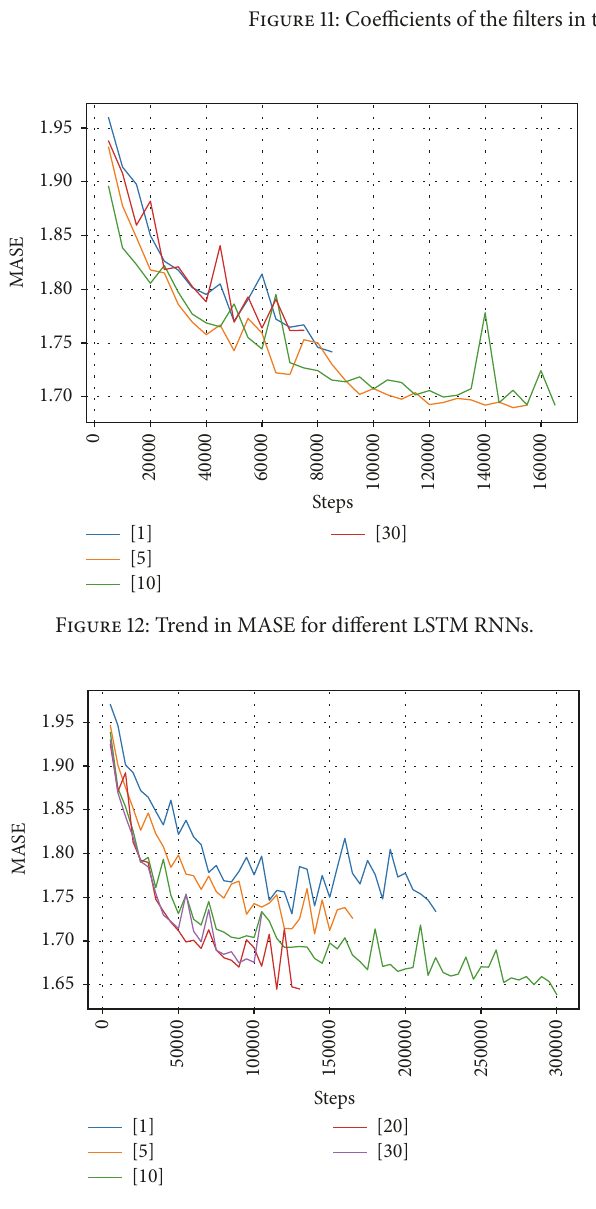
Figure 13: Trend in MASE for different GRU RNNs.